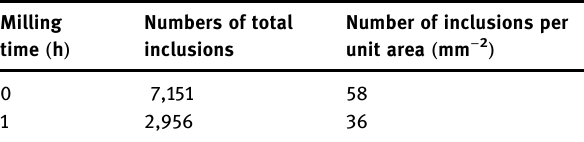
Table 1: Total inclusions and inclusions per unit area for